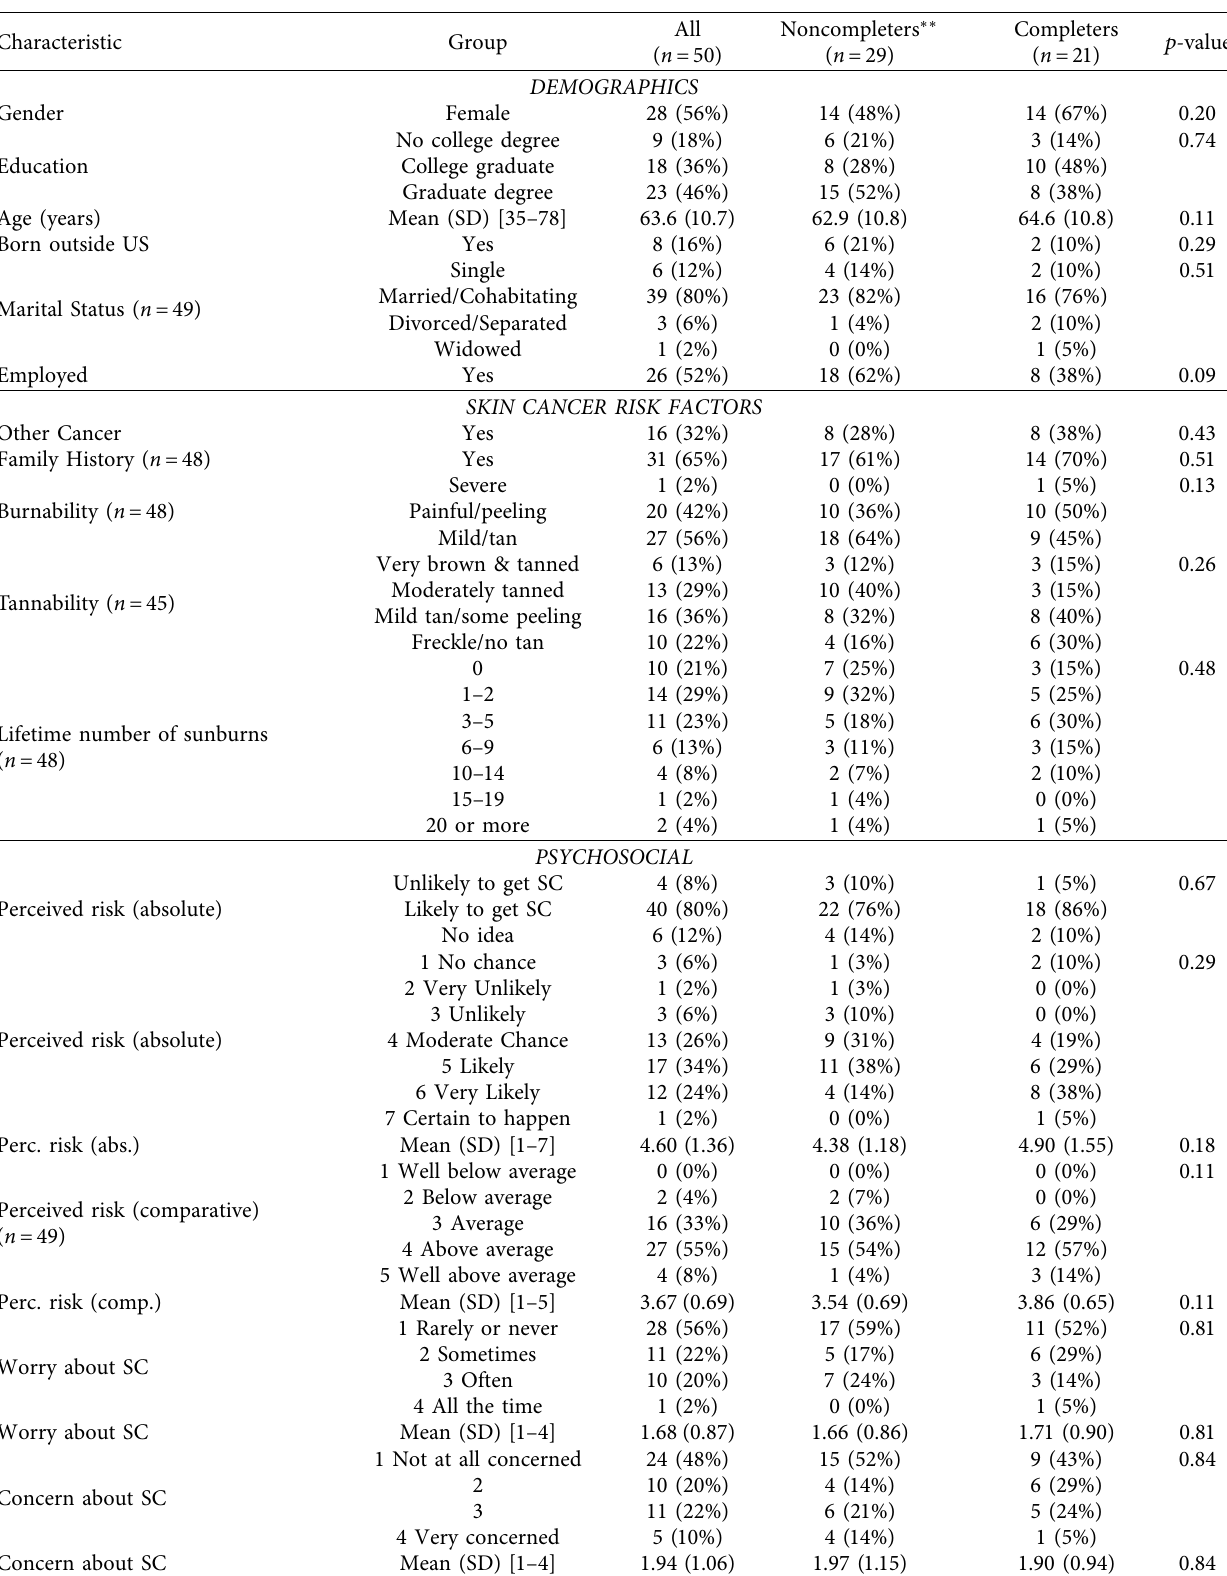
Table 1: Participant baseline characteristics, overall, and saliva sample return